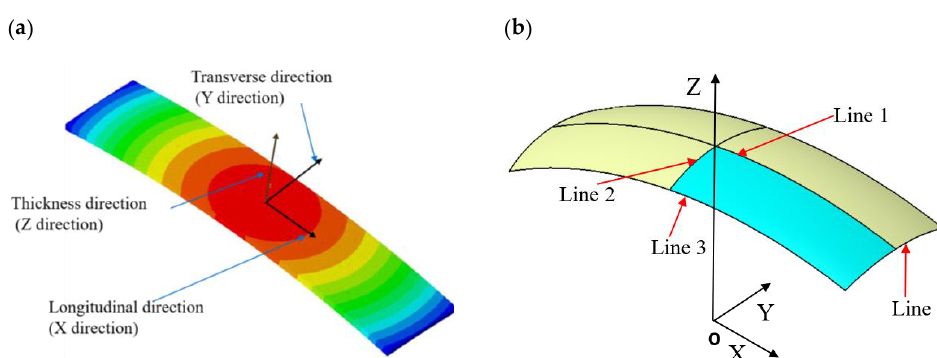
Figure 11. Shot peen forming. ( a ) Vertical deflection of a quarter Almen strip with a total arc height of 1.1 mm. ( b ) Four lines evaluated as the deflections along axes X and Y.